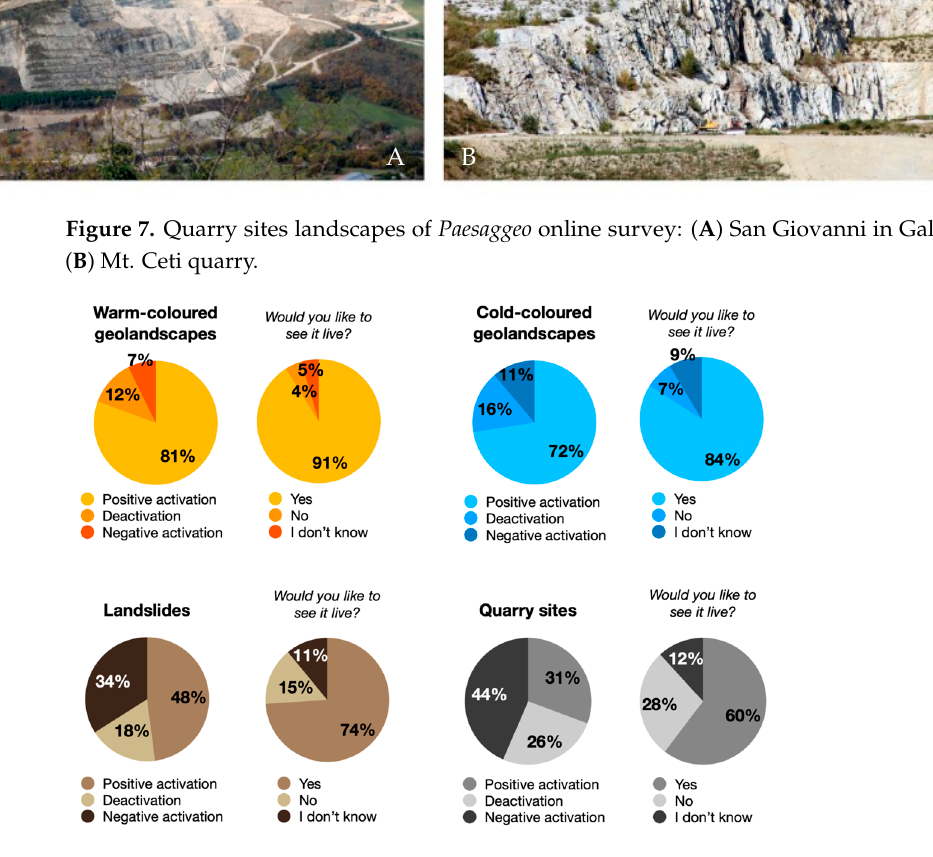
Figure 8. Summarized results from Paesaggeo’ s online survey.